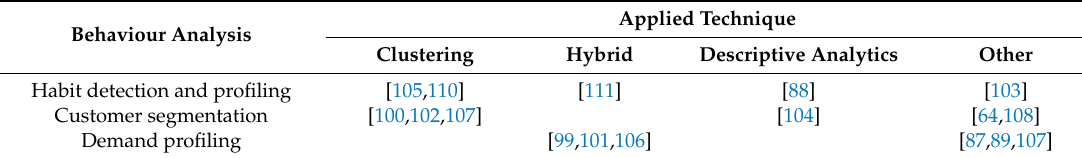
Table 6. Summary of studies on behaviour analysis.